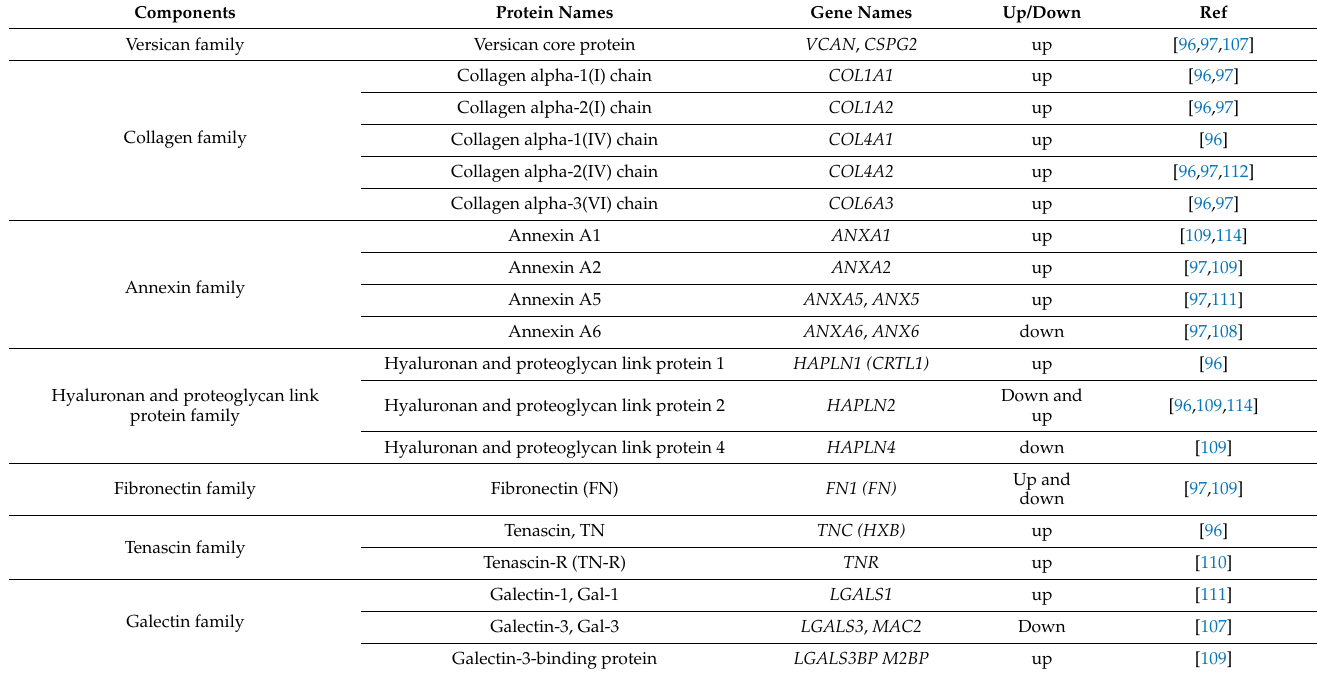
Table 3. Commonly reported differentially expressed ECM-related proteins from postmortem tissue of PD patients compared with healthy controls (reported from, at least, two of the included studies).